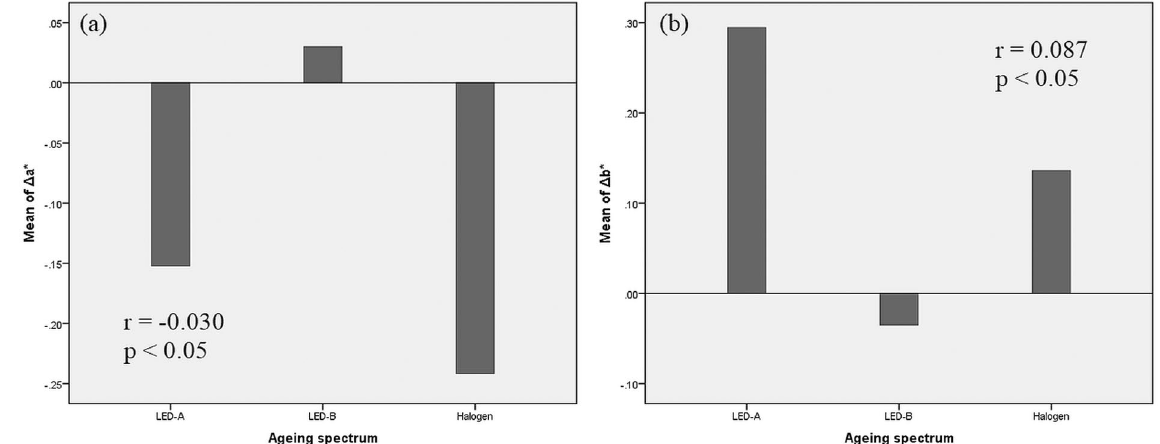
Figure 5. Correlation between ( a ) CIELAB Δa* (red–green), ( b ) CIELAB Δb* (yellow–blue) and lighting systems (LED A—420 nm, LED B—460 nm, HL—halogen